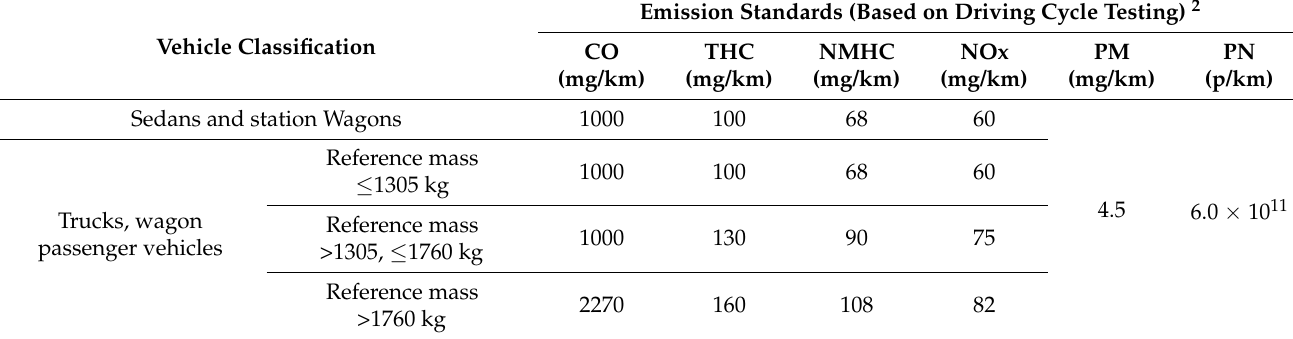
Table 4. The standards of engine exhaust emissions from gasoline and clean alternative fuel in Taiwan 1 .